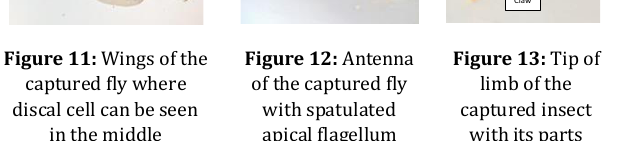
Figure 1: An adult Black soldier fly (dorsal aspects) found near the organic waste bin